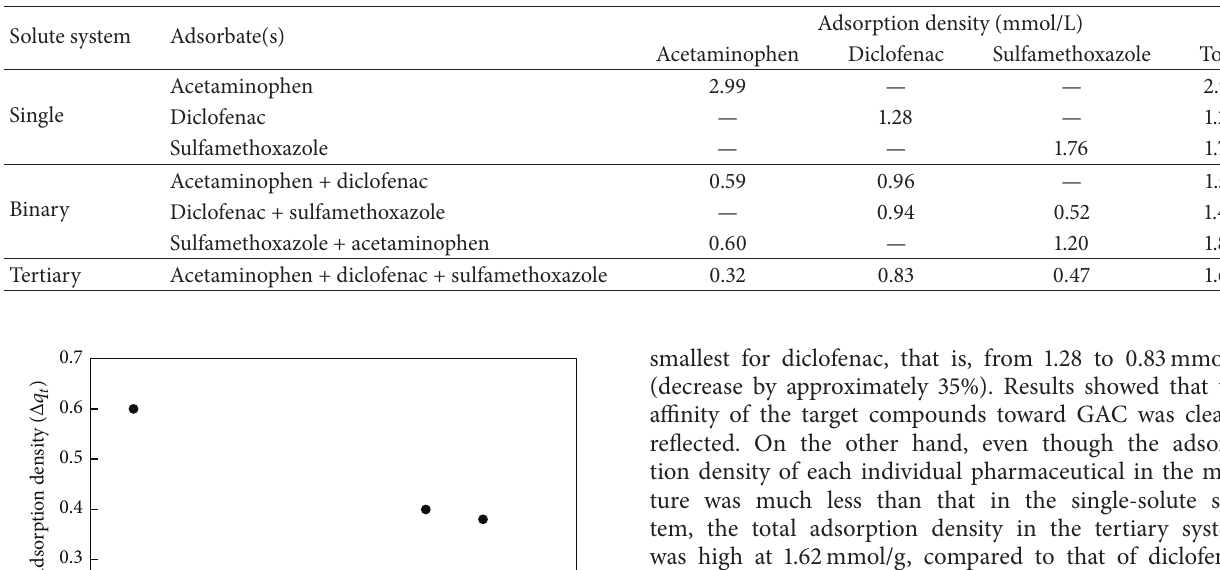
Table 5: The adsorption density of each target compound under single, binary, and tertiary systems.